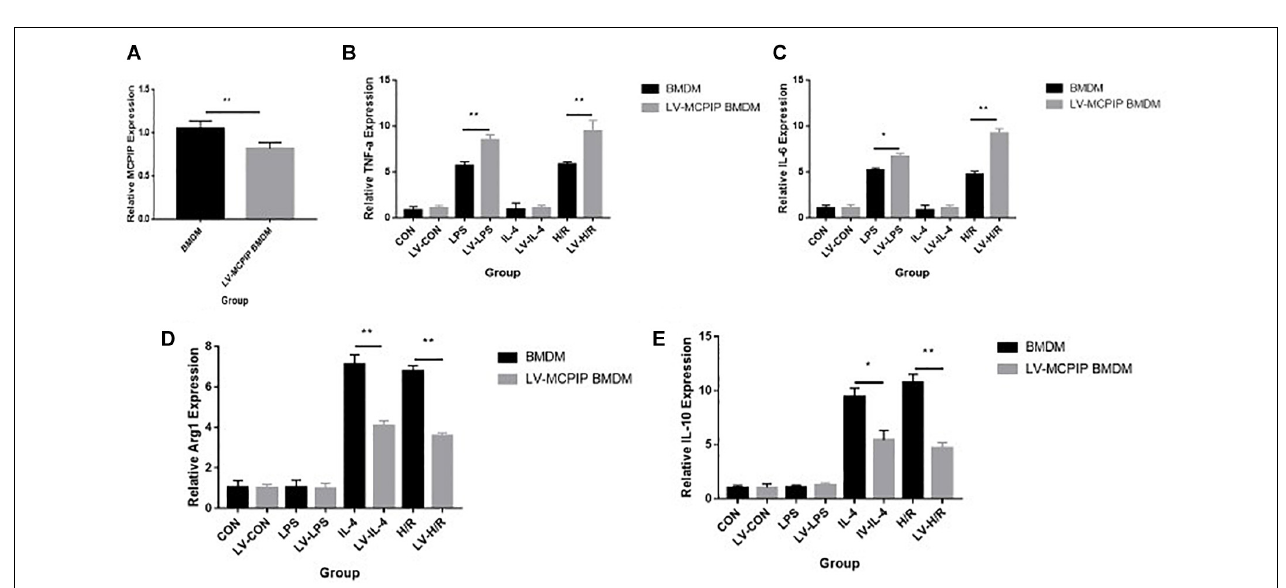
FIGURE 4 | The percentage of M1 and M2 subsets of BMDM with or without MCPIP deficiency was detected by flow cytometry.